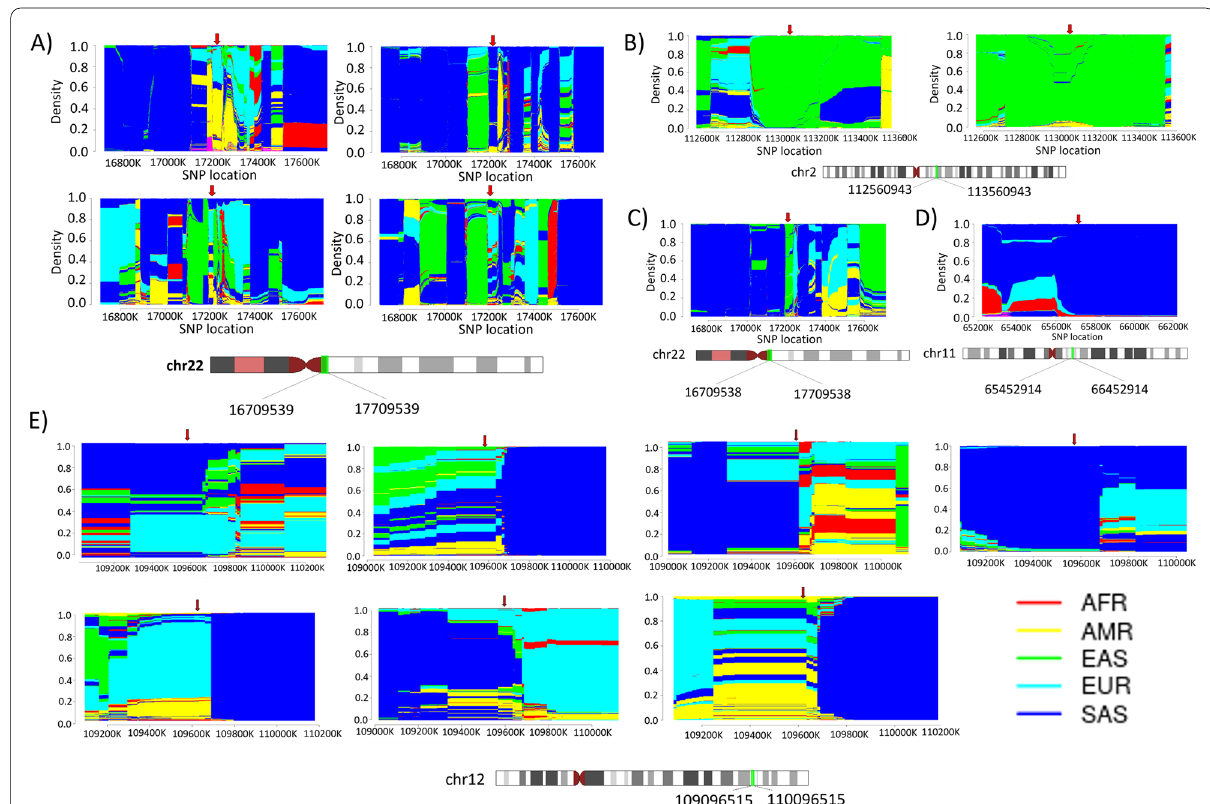
Fig. 4 Visualization of haplotype ancestry of founder variants in IndiGen individuals with 5MB upstream and downstream mapped to the five superpopulation of 1000 Genome Project A ) The chromosomal painting of Georgian Jewish founder variant rs202134424-T (marked with red arrow) in four IndiGen individuals. B ) The chromosomal painting of East Asian founder variant rs148755083 (marked with red arrow) in two IndiGen individuals. C ) The chromosomal painting of Georgian Jewish founder variant rs202134424-G found in a single IndiGen individual. D ) The chromosomal painting of Asian founder variant rs78635798 (marked with red arrow) in a single IndiGen individual. E ) The chromosomal painting of Dutch population founder variant rs28934897 in seven IndiGen individuals. AFR Africa, AMR America, EAS East Asia, EUR European, SAS South